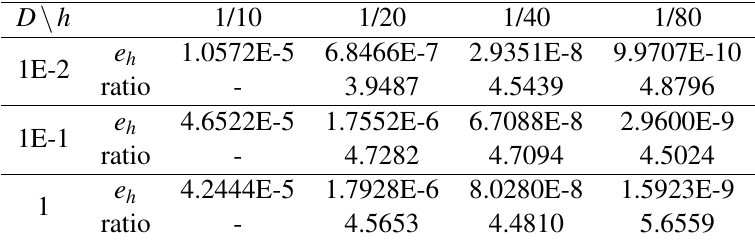
Table 1 Errors and ratios of convergence in space for different diffusion D .